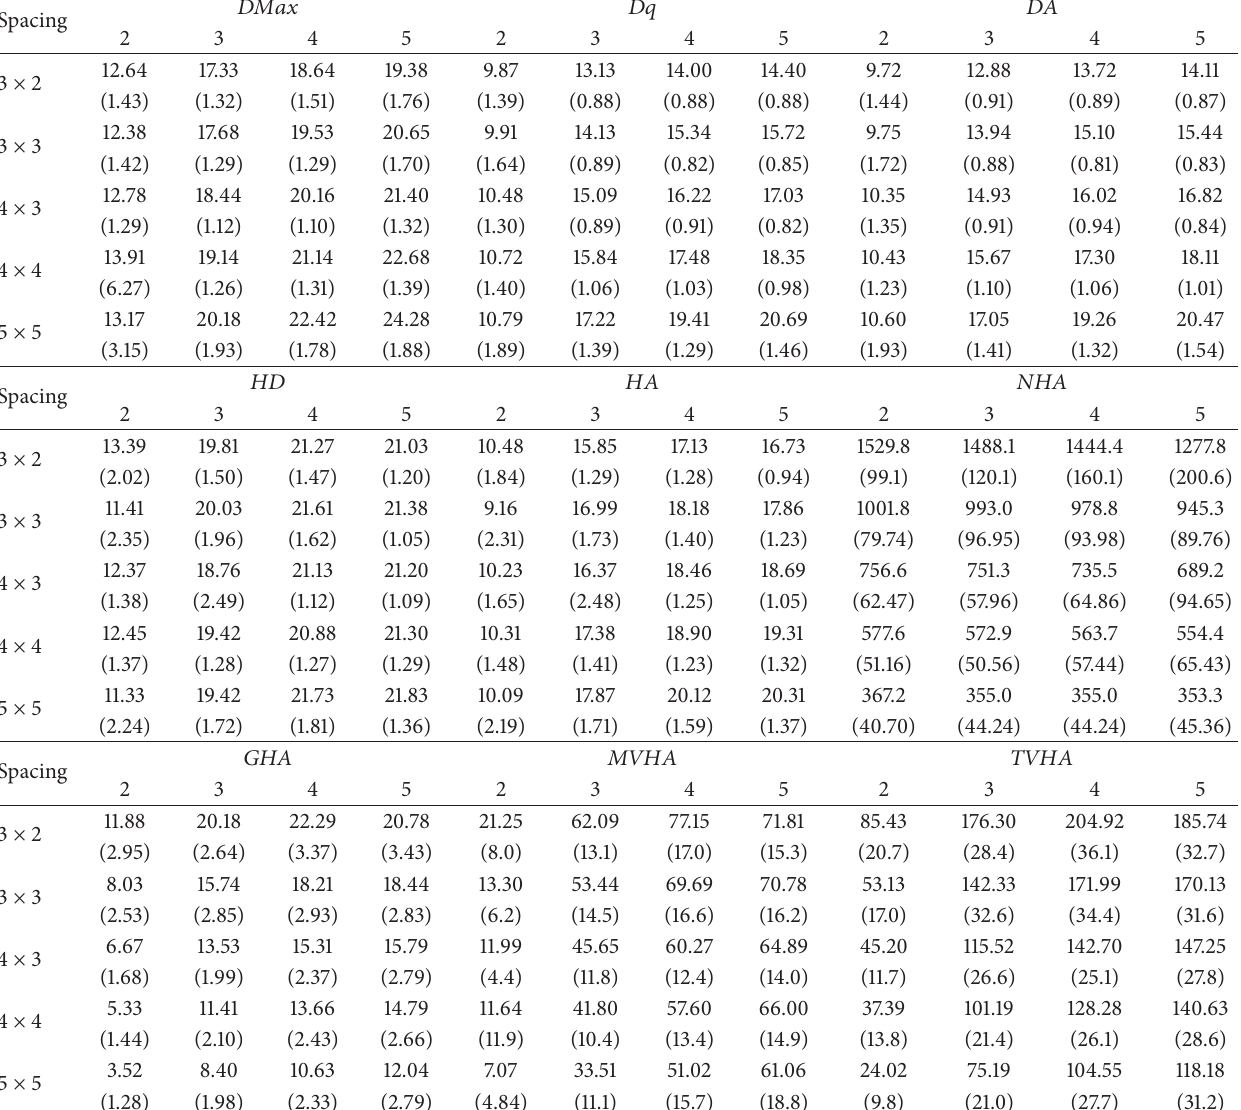
Table 1: Average and standard error (in parentheses) for selected stand variables at different combinations of spacing and age. Spacing